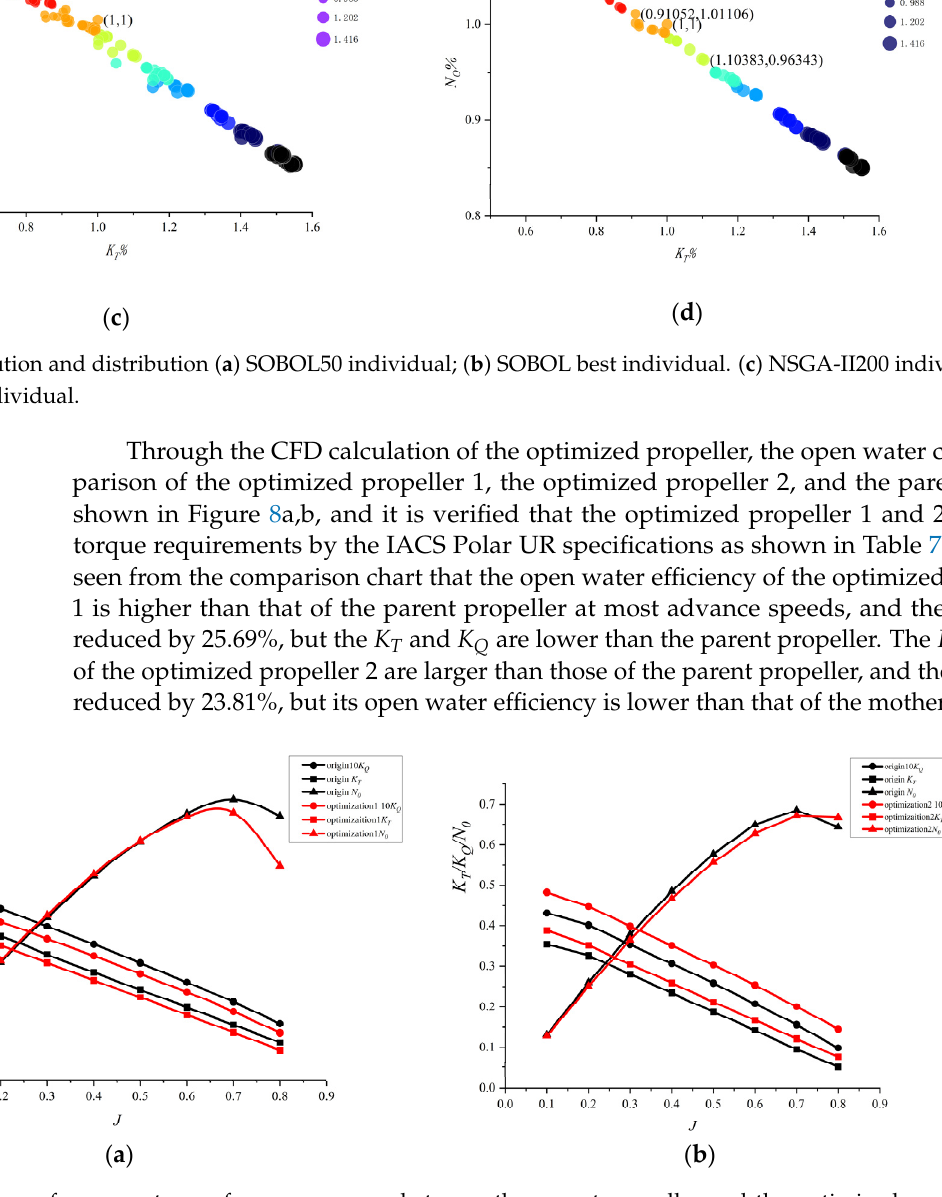
Figure 8. Comparison of open water performance curves between the parent propeller and the optimized propeller. ( a ) Comparison chart of parent propeller and optimized propeller 1; ( b ) comparison chart of parent propeller and optimized propeller 2. Table 7. Verification of ice torque by IACS Polar UR.